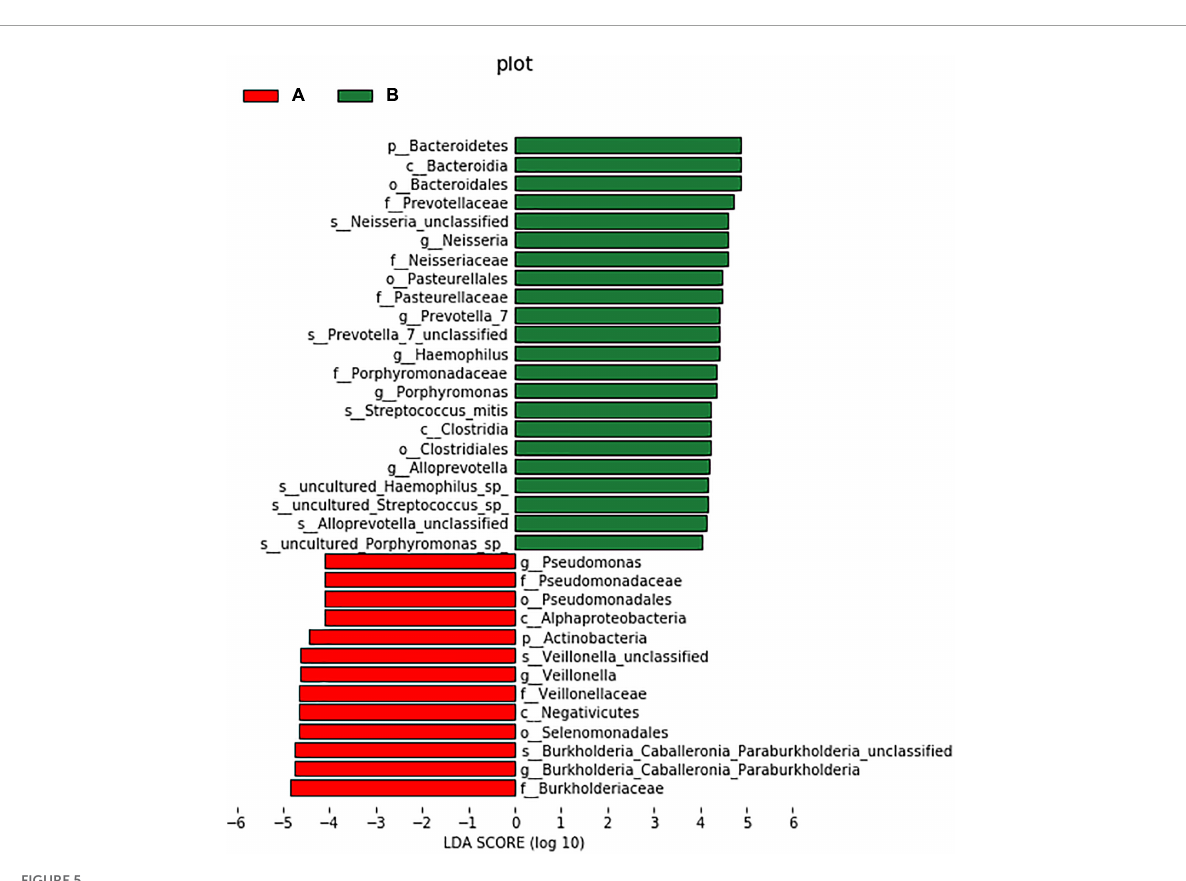
the results may be different. For example, smoking will lead to a significant increase in the abundance of Streptococcus, and a decrease in common symbiotic bacteria (11). However,